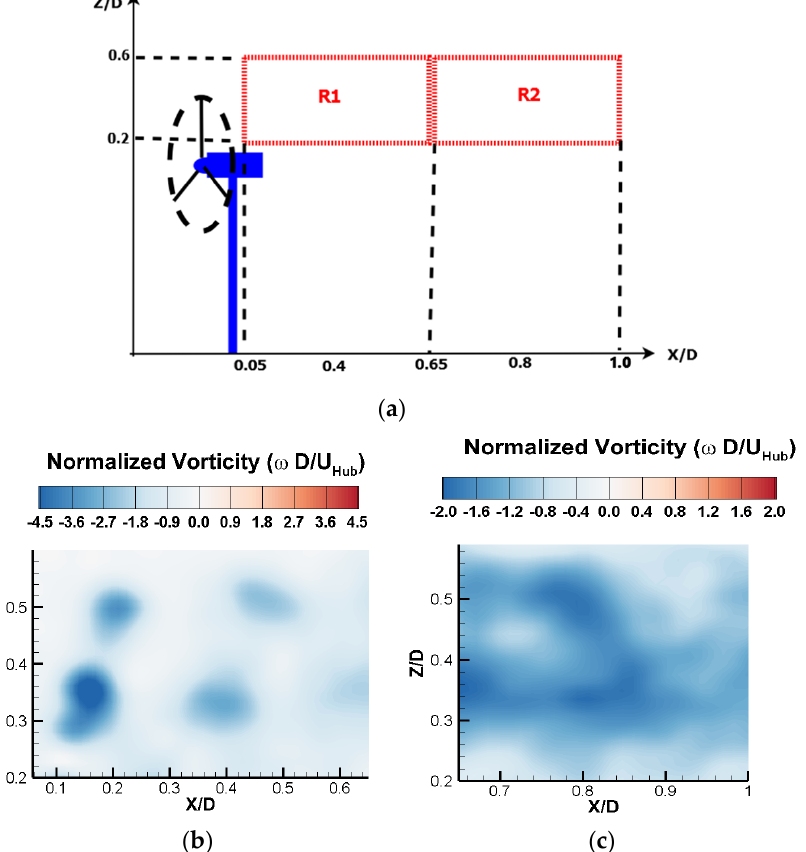
Figure 6. Regions of interest and the corresponding phase-averaged vorticity solutions for 𝜃 = 0 ° . ( a ) Regions of Interest (R1 and R2). ( b ) R1 Normalized Vorticity. ( c ) R2 Normalized vorticity.